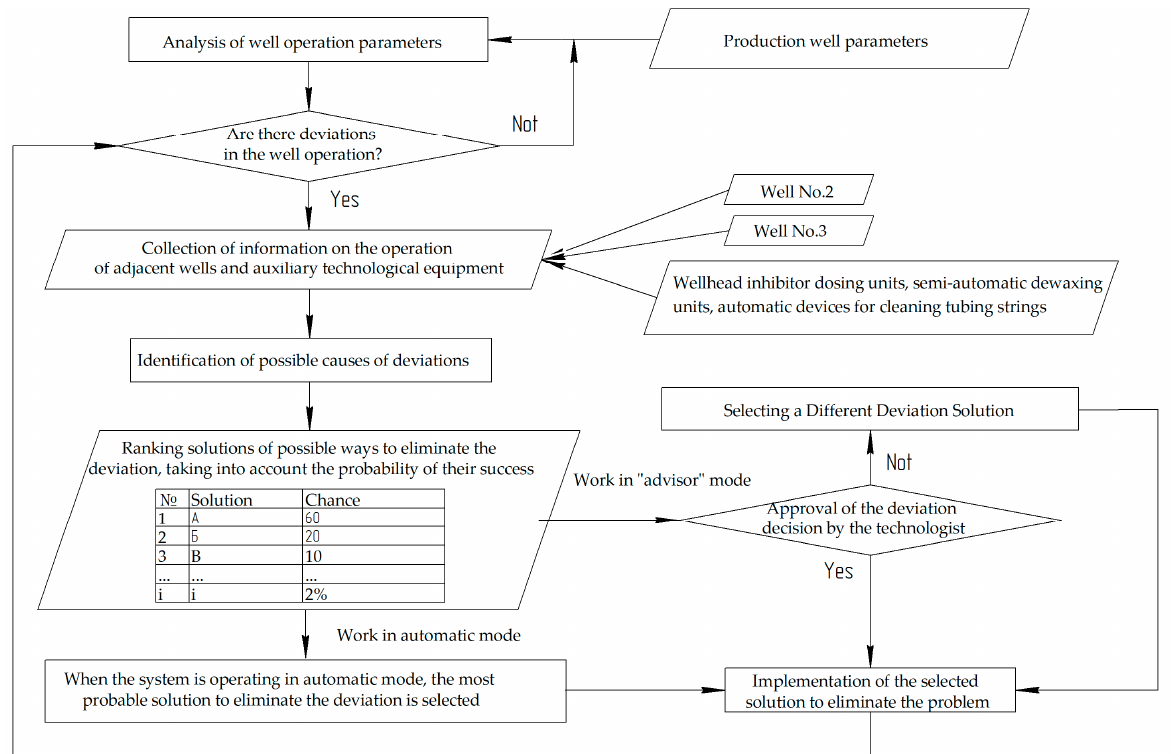
Figure 3. Scheme of operation of the “Complications” module of the automated well cluster control system.